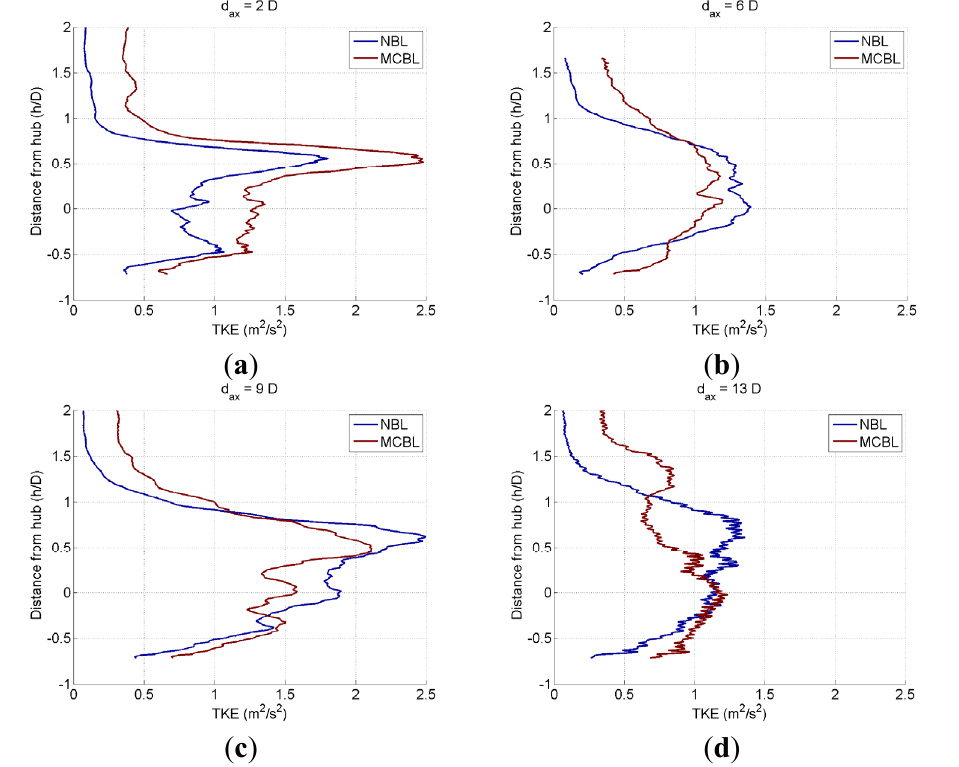
Figure 12. Turbulent Kinetic Energy (TKE) distribution in the vertical direction. (Turbine-Turbine Interaction Problem, V Wind = 8 m/s). ( a ) 2D downstream of Turbine 1; ( b ) 6D downstream of Turbine 1; ( c ) 2D downstream of Turbine 2; ( d ) 6D downstream of Turbine